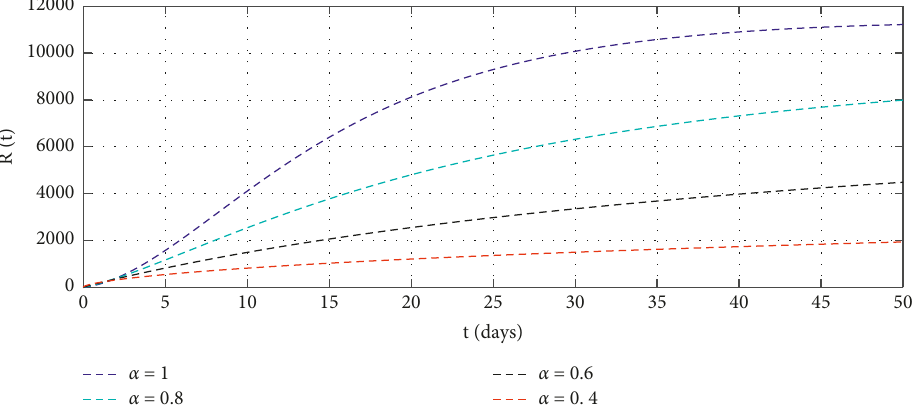
Figure 3: Simulations of recovered individuals with different memory effect.